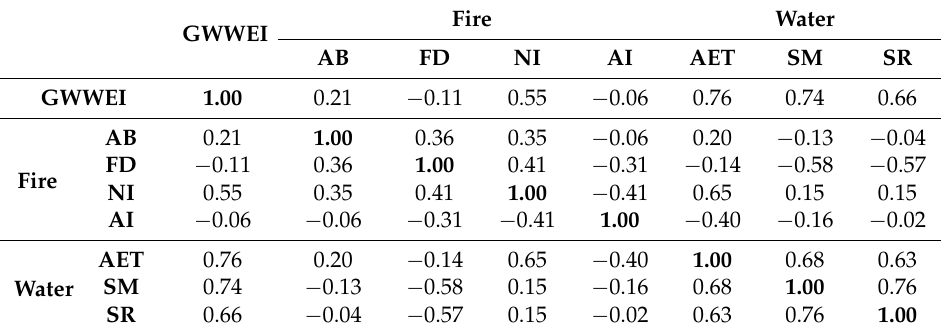
Table 3. Spearman correlation coefficients between the GWWEI and source indicators, as well as between